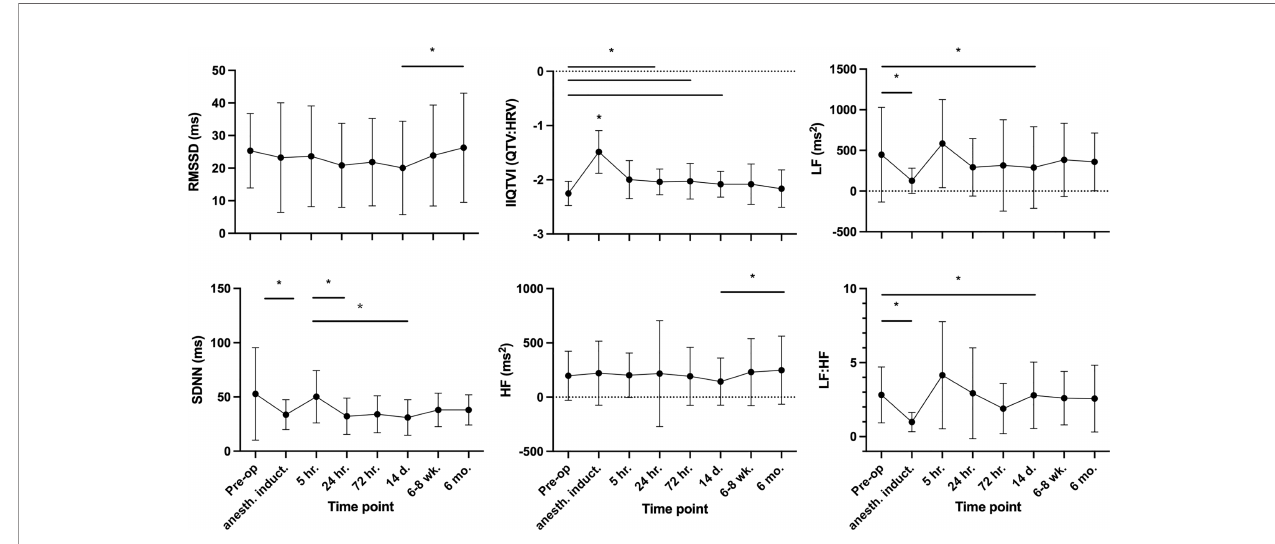
FIGURE 3 | Temporal HRV trajectories. Mean values, SD. For the indexed parameter IIQTVI and the ratio LF : HF, a greater value implies less variability. * P-values ≤ 0.05, Tukey´s multiple comparison